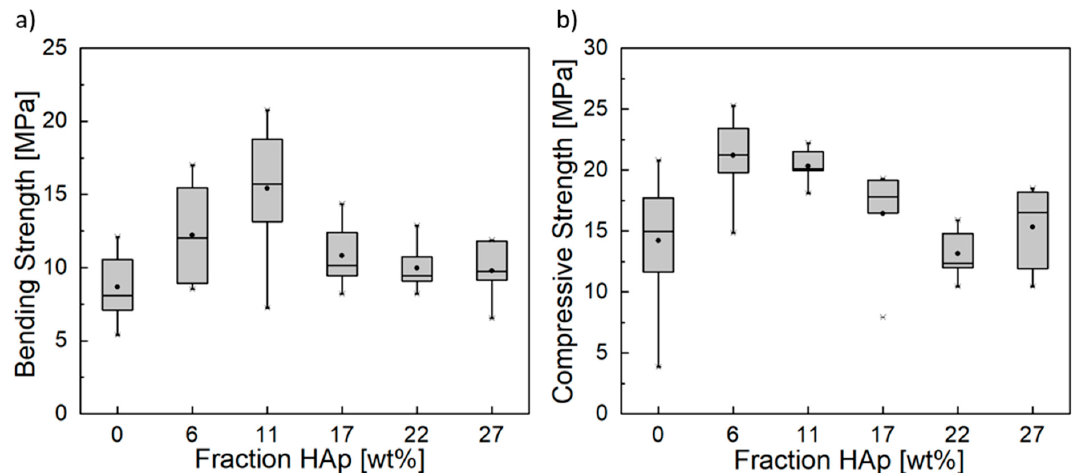
Figure 2. ( a ) Bending and ( b ) compressive strength of Hap-reinforced CPC.